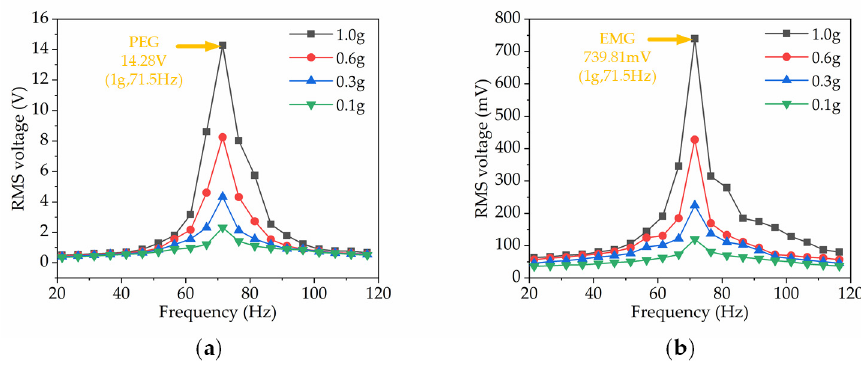
Figure 4. Frequency response of the PEG and EMG of a typical HEH: ( a ) PEG; ( b ) EMG.